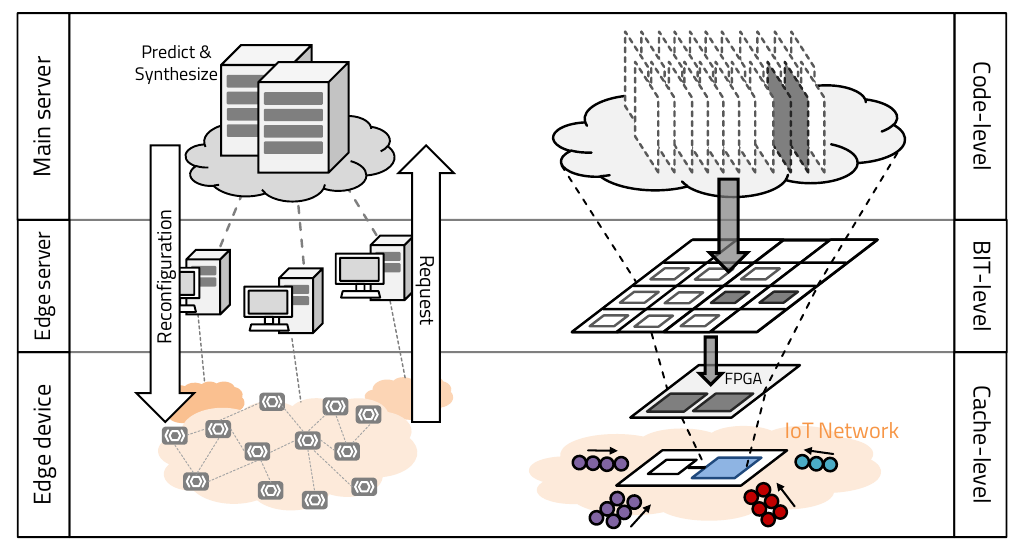
Figure 2. mIoT’s overall